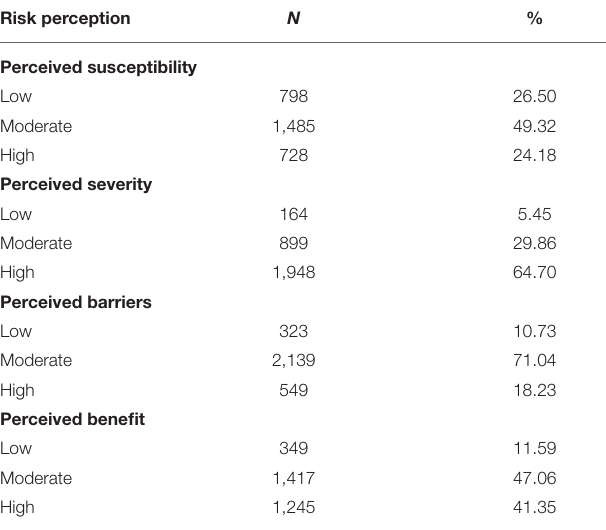
TABLE 1 | Risk perception among 3,011 reproductive women in China during COVID-19